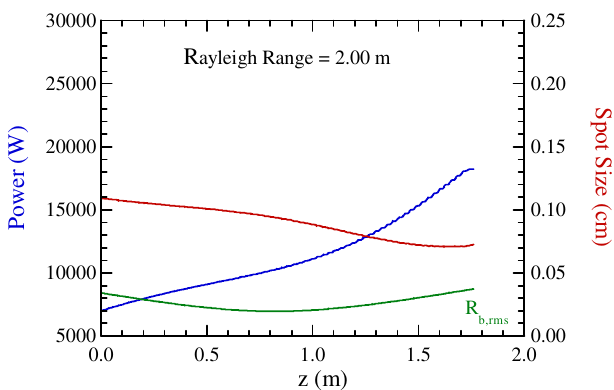
FIG. 9. (Color) Evolution of the power (blue), optical spot size (red), and rms beam radius (green) for a Rayleigh range of 2.0 m.